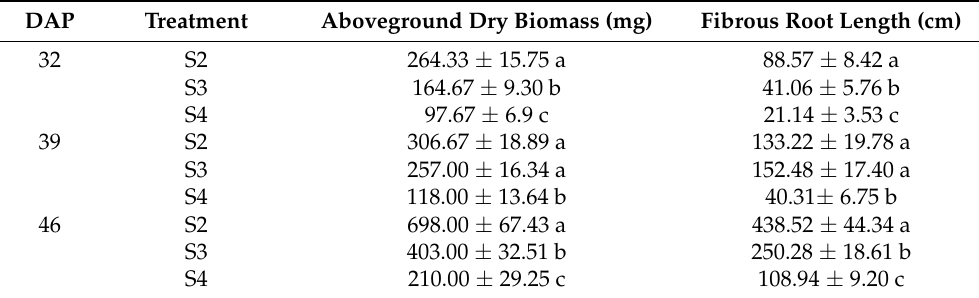
Table 3. The aboveground dry biomass and fibrous root length on three dates in EXP.2. Data shown are Mean ± s.e. ( n = 3).